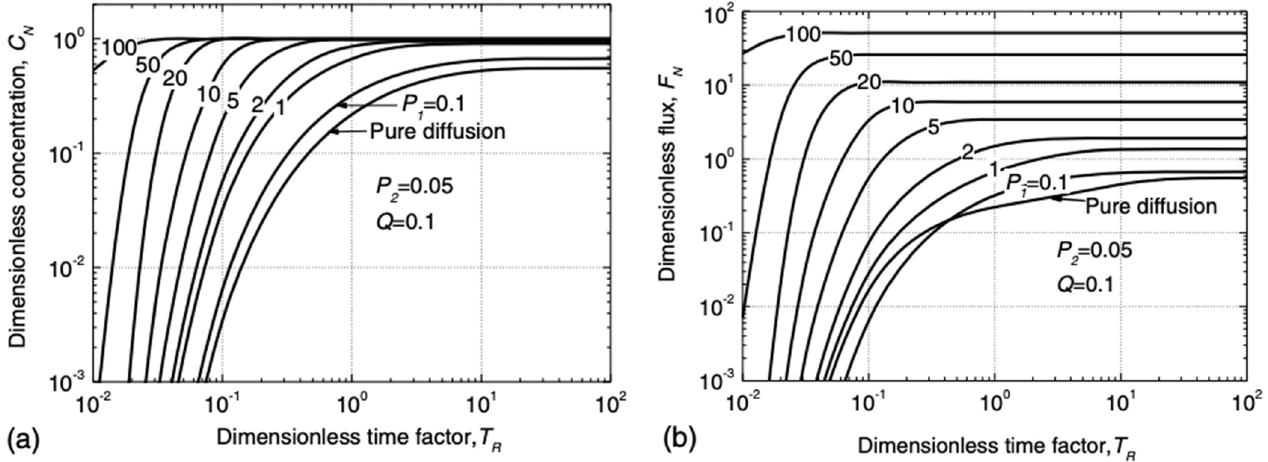
Figure 6. Variation curve of C N and F N of pollutant with P 1 ( P 2 = 0.05, Q = 0.1): ( a ) dimensionless concentration C N ; ( b ) dimensionless flux F N . Reprinted with permission from Ref. [15], Copyright 2018 ASCE Library.